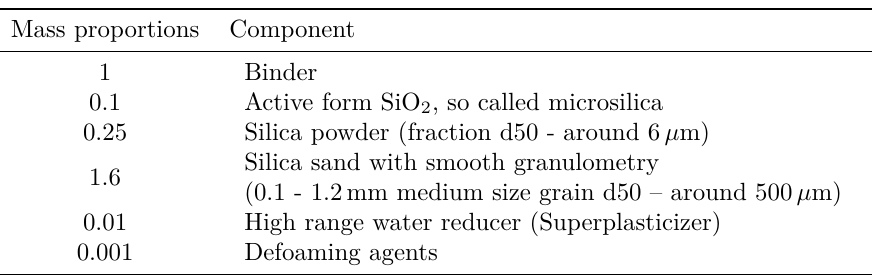
Table 1. Components of the prefabricated mixture – proportions by weight.